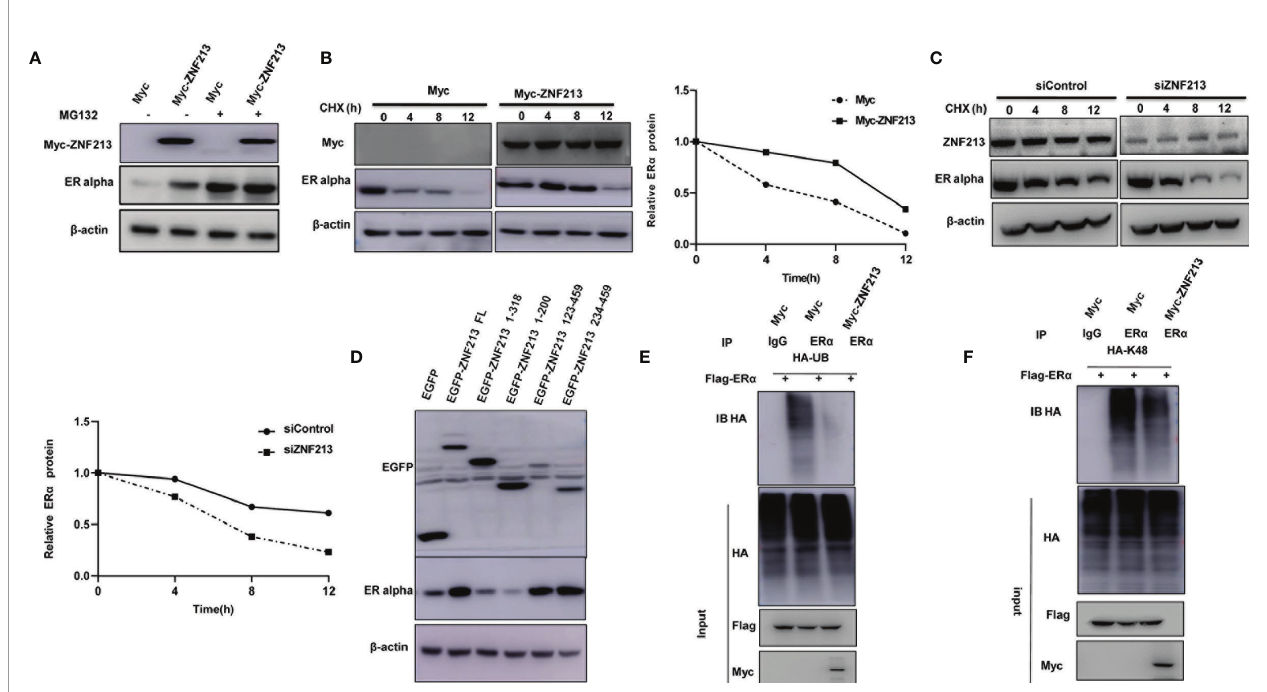
FIGURE 5 | ZNF213 modulates ER alpha poly-ubiquitination and protein stability (A) In the presence of the proteasome inhibitor MG132, the stabilization effect of ZNF213 on ER alpha did not further increase ER alpha protein levels. HEK293 cells were transfected with 2 µg ER alpha plasmid and 0.5 µg Myc-tag or Myc- ZNF213 plasmids. After 24 h, cells were treated with 10 uM MG132/vehicle for 6 h. Cell lysates were prepared for Western blot analysis. The results are representative for three independent experiments. (B) ZNF213 increases ER alpha half-life in HEK293 cells. HEK293 cells were transfected with HA-ER alpha plasmid and Myc-tag or Myc-ZNF213 plasmids. After 24 h, cells were treated with 100 µM cycloheximide/vehicle for indicated times. Cell lysates were prepared for Western blot analysis. The results are representative for three independent experiments. The ER alpha relative density was measured by Image J software. (C) ZNF213 increases ER alpha half-life in MCF-7 cells. Cells were transfected with siZNF213 or siControl. After 48 h, cells were treated with 100 µM cycloheximide/vehicle for indicated times. Cell lysates were prepared for Western blot analysis. The results are representative for three independent experiments. The ER alpha relative density was measured by Image J software. (D) The ZF domain is required for ZNF213 to stabilize ER alpha in HEK293 cells. (E) ZNF213 prohibits ER alpha poly- ubiquitination. HEK293 cells were transfected with 2 µg ER alpha plasmid and 0.5 µg Myc-tag or Myc-ZNF213 plasmids. After 24 h, cells were treated with 10 uM MG132 for 6 h. Cells were directly harvested and Western blot analysis using ER alpha antibody was used to detect ubiquitinated ER alpha forms. The predicted molecular weight of poly-ubiquitinated ER alpha is indicated. (F) ZNF213 decreases K48-linked poly-ubiquitination of ER alpha. HEK293 cells were transfected with